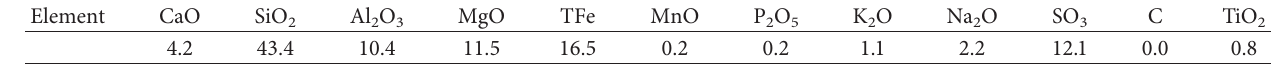
Table 4: The main chemical compositions of the tailings used (wt.%).